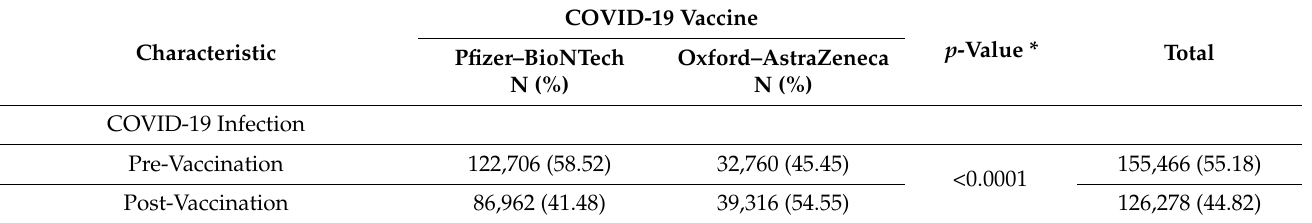
Table 1. Persons’ baseline